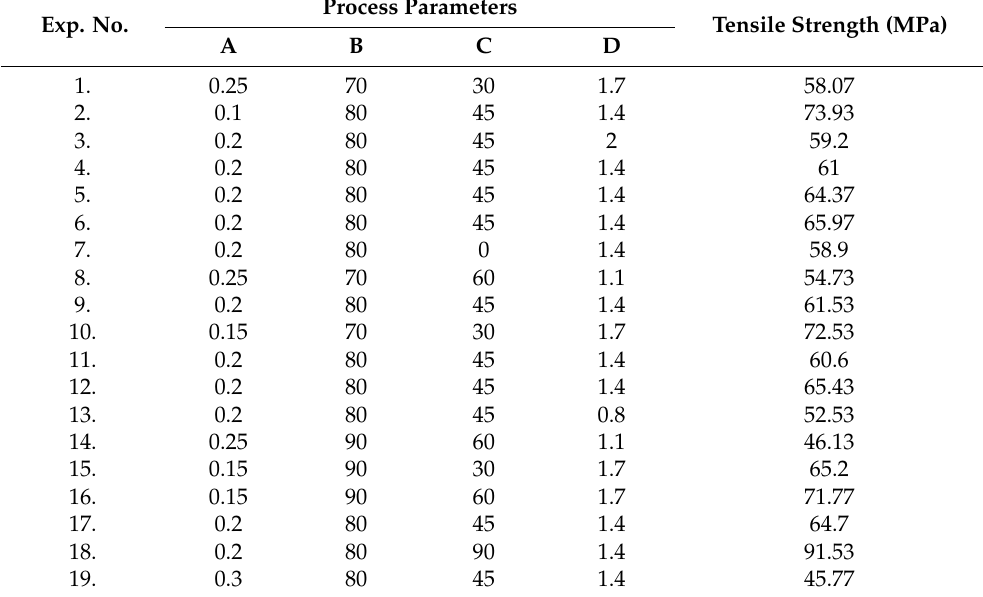
Table 4. The experimental